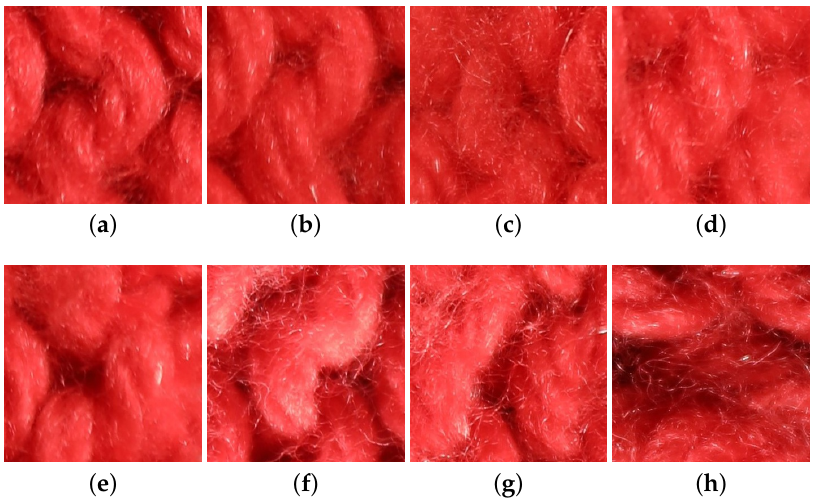
Figure 9. Changes in visual appearance of a wool sample under various lighting geometries and viewing directions. Images ( a – d ) were acquired under the same lighting direction (90°). Images ( e – h ) were acquired under the same viewing direction (90°). For images ( a – d ), the lighting direction is fixed at 90°, and the viewing directions are 90°, 60°, 35°, and 10°, respectively. For images from ( e – h ), the viewing direction is fixed at 90° and the lighting directions are 90°, 65°, 45°, and 20°, respectively.